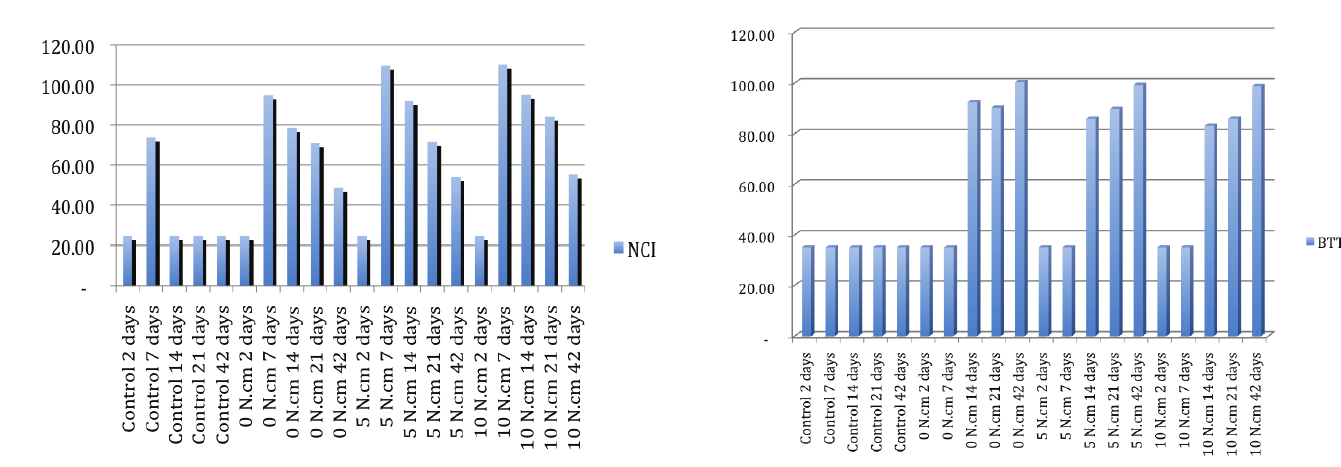
FIGURE 5 - Analyzing torque X time and ICN. FIGURE 6 - Analyzing torque X time and the mean of